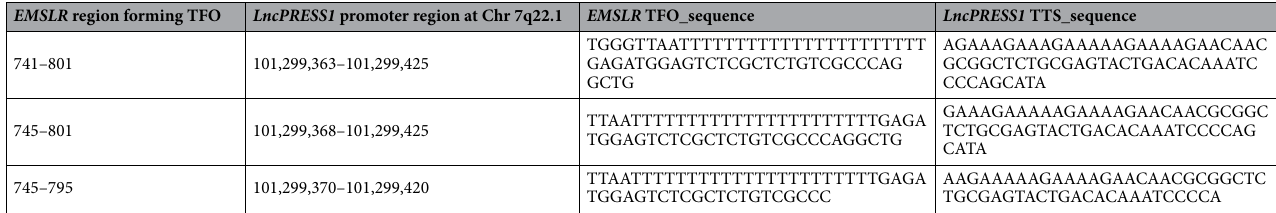
Table 1. The LongTarget program prediction of the triplex formation oligonucleotides (TFO) of EMSLR and their triplex targeting sites (TTS) within LncPRESS1 promoter based on Hoogsteen and reverse Hoogsteen base-pairing